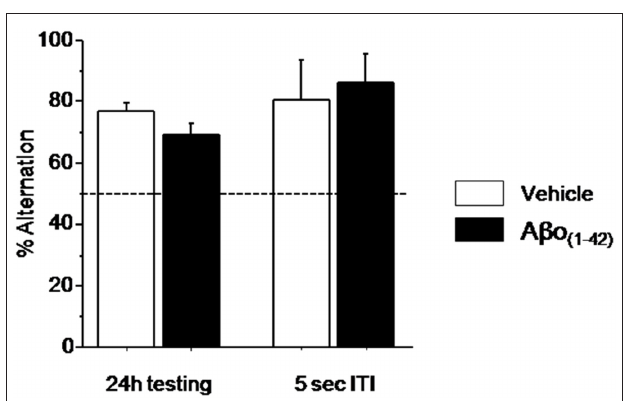
FIGURE 5 | Effects of intra-dCA1 A β o ( 1 – 42 ) injections on spatial delayed memory in the water maze . Percentage of alternation was measured in A β o ( 1–42 ) ( n = 13) and Vehicle ( n = 7) groups at 24 h and 5 s ITI. There was significant between-group difference when animals were tested 24 h after the acquisition whereas intra-dCA1 A β o ( 1–42 ) injections did not affect spatial delayed memory at 5 s